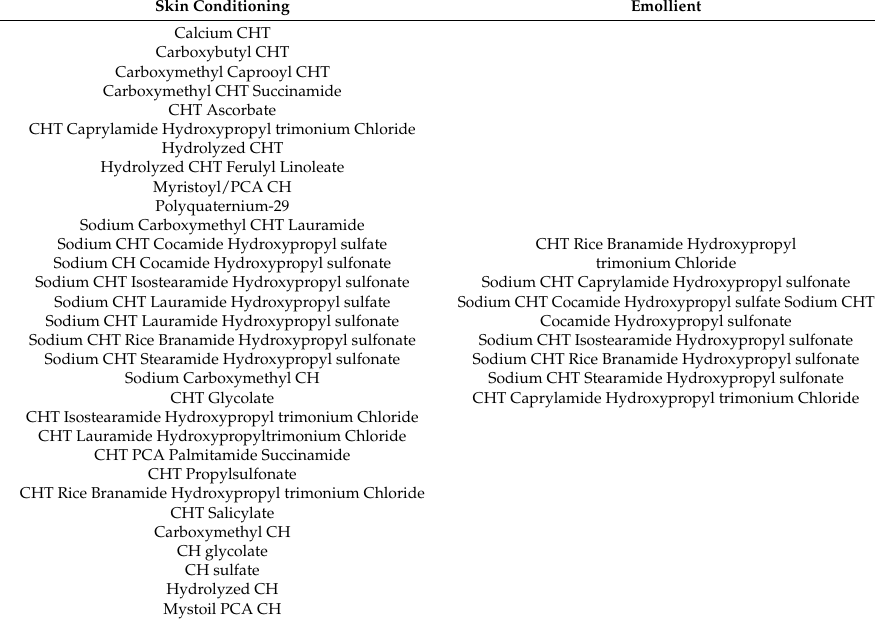
Table 9. Chitin and Chitosan derivatives with function as a skin conditioning and emollient in CosIng